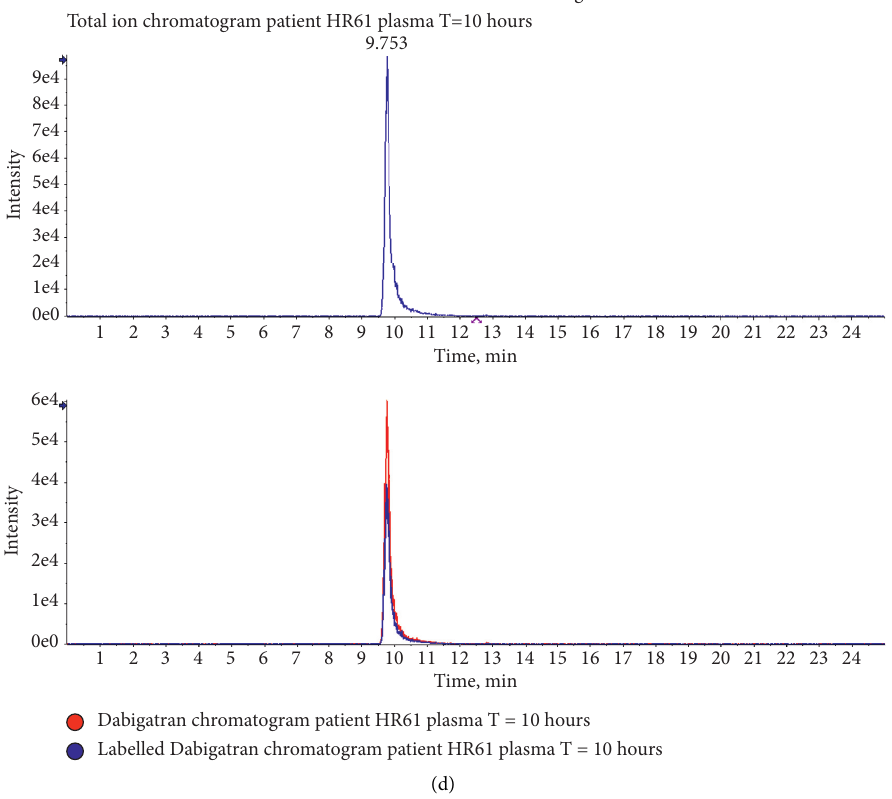
Figure 2: Chromatograms of dabigatran extracted from plasma and breast milk obtained from a patient before ( T � 0) and 10h ( T � 10h) after the ingestion of dabigatran etexilate. (a) Breast milk T 0 chromatogram, (b) breast milk T � 10hours chromatogram, (c) plasma T 0 chromatogram, and (d) plasma T � 10 hours